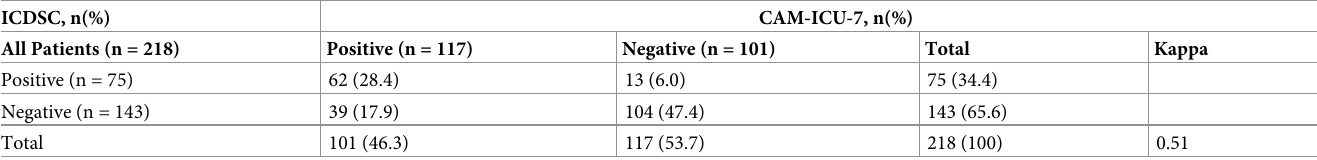
Table 2. Correlation between CAM-ICU-7 and ICDSC as delirium measures.